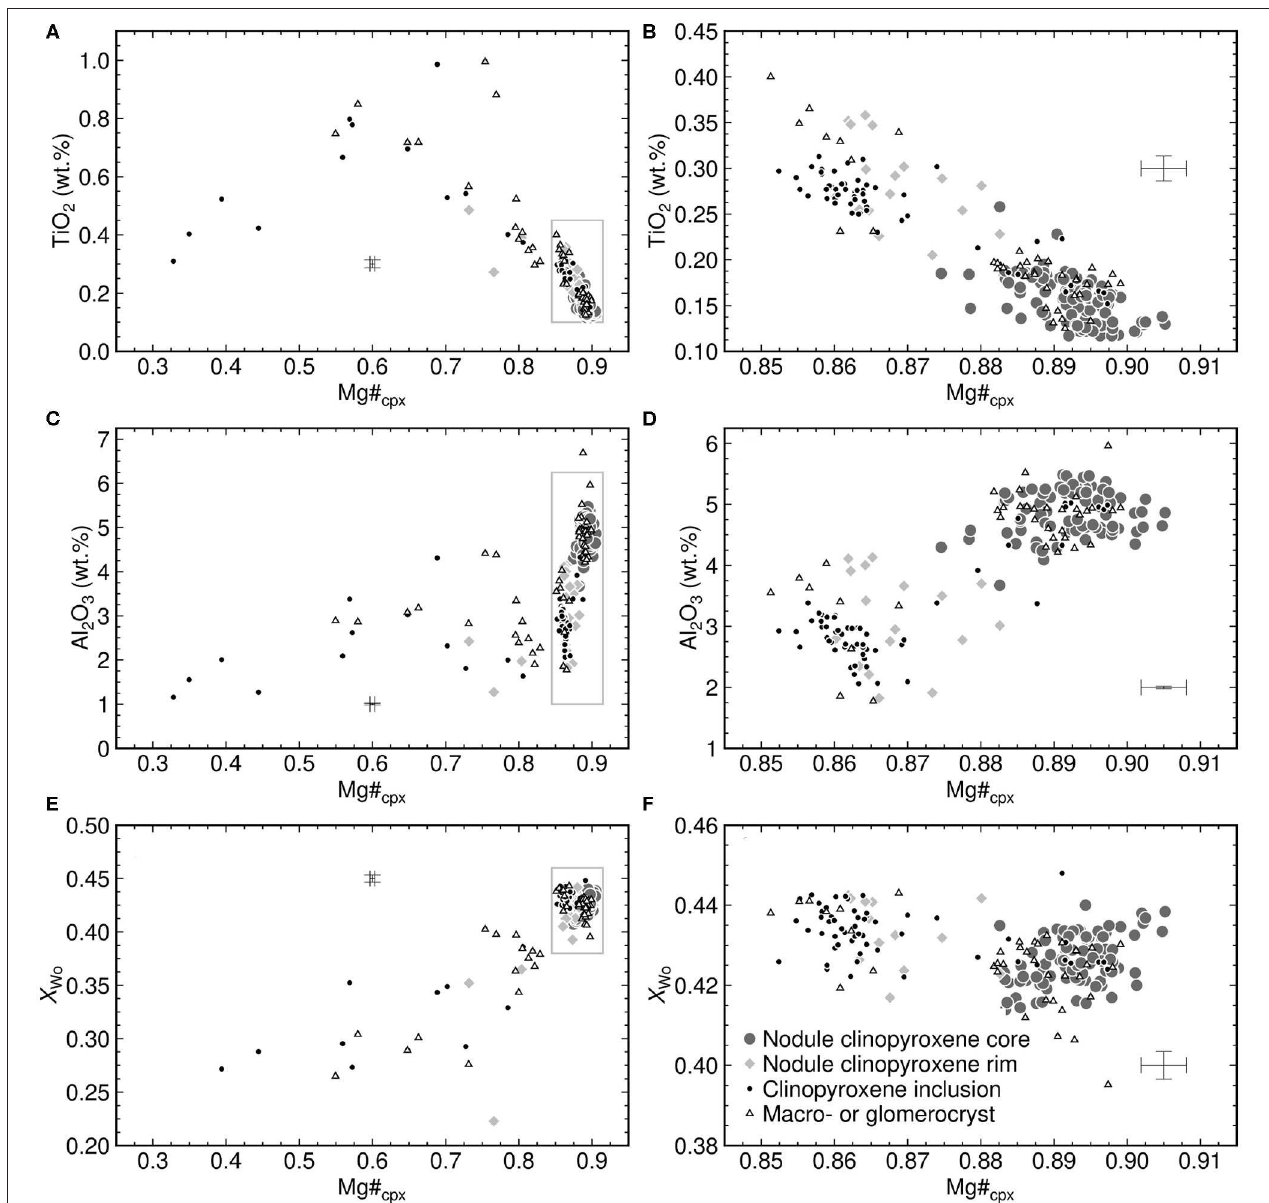
FIGURE 5 | Clinopyroxene compositions in sample JM27 from the Borgarhraun lava flow in North Iceland. Analyses are divided into four textural associations: nodule cores, nodule rims, inclusions, and macrocrysts or glomerocrysts. 2 σ analytical uncertainties based on repeat measurements of the Ney County Cr-Augite (NMNH 164905) are shown (Jarosewich et al., 1987). (A,B) Plots of Mg# cpx [where Mg# cpx molar Mg/(Mg+Fe)] vs. TiO 2 . (C,D) Plots of Mg# cpx vs. Al 2 O 3 . (E,F) Plots of = Mg# cpx vs. wollastonite component [ X Wo , where X Wo Ca/(Ca+Mg+Fe) on a molar basis]. (B,D,E) Show the regions outlined with gray box in (A,C,E) =